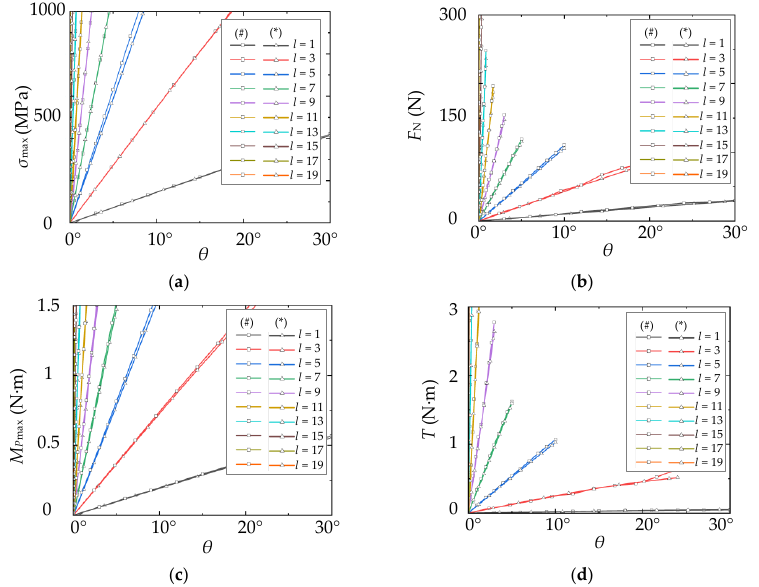
Figure 16. Calculation results according to the model and simulation. ( a ) σ max − θ ; ( b ) F N − θ ; ( c ) M P max − θ ; ( d ) T − θ . (#) represents calculation results according to the model, while (*) represents simulation results.